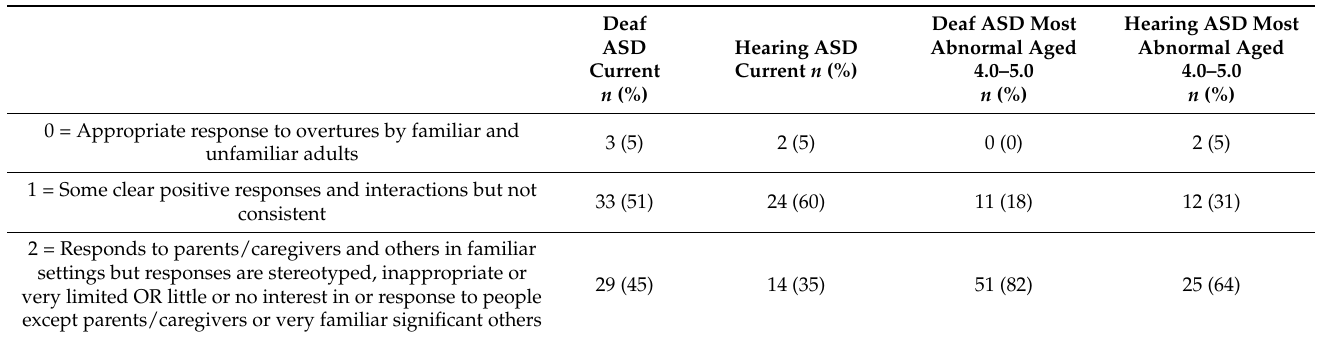
Table 8. Appropriateness of social